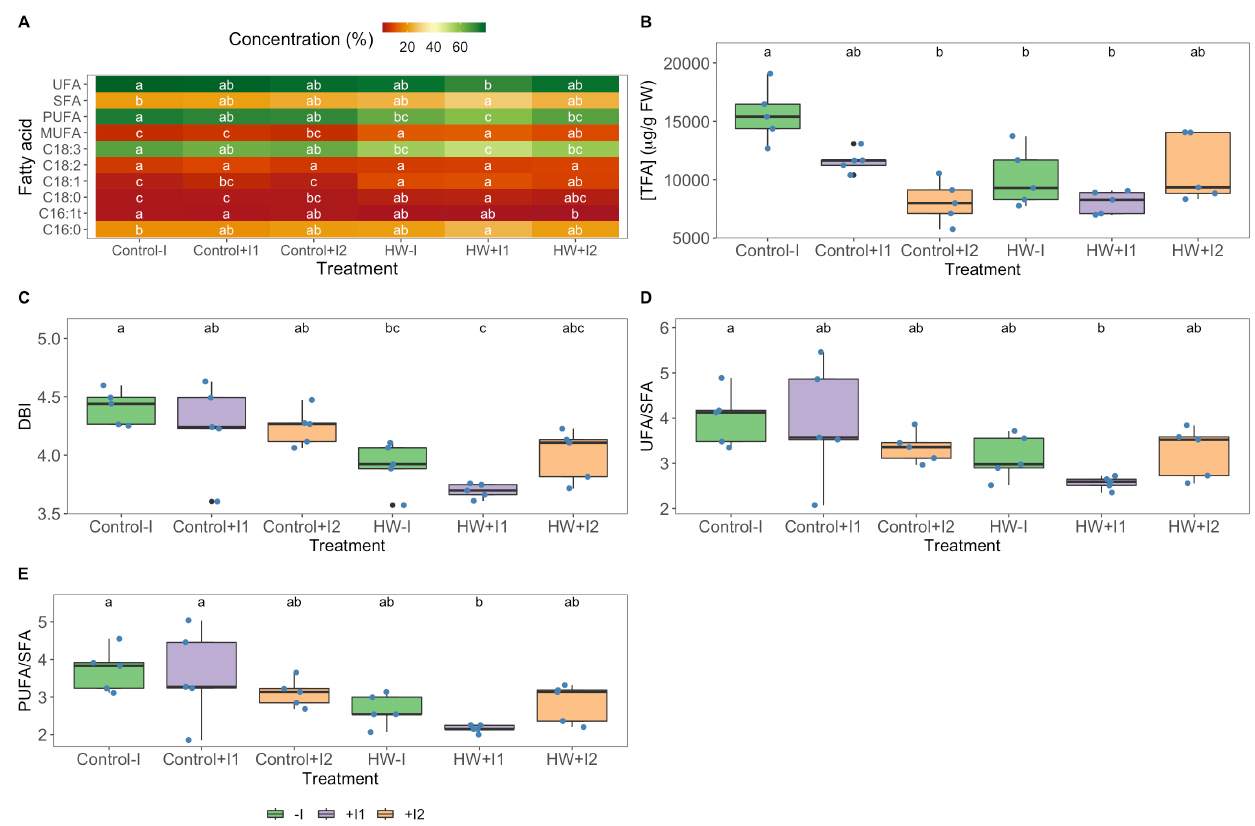
Figure 9. ( A ) Individual fatty acid and saturation class relative concentrations (monounsaturated fatty acids (MUFA)); polyunsaturated fatty acids (PUFA); saturated fatty acids (SFA); unsaturated fatty acids (UFA)); ( B ) total fatty acid content (TFA); ( C ) double bound index (DBI); ( D ) UFA/SFA ratio; ( E ) PUFA/SFA ratio in leaves of non-inoculated ( − I) and marine PGPR consortia 1- and 2- inoculated (+I) Vitis vinifera , under normal (control) thermal regimes and exposed to heatwave (HW) (average ± standard deviation, N = 5, letter denotes significant differences at p < 0.05).